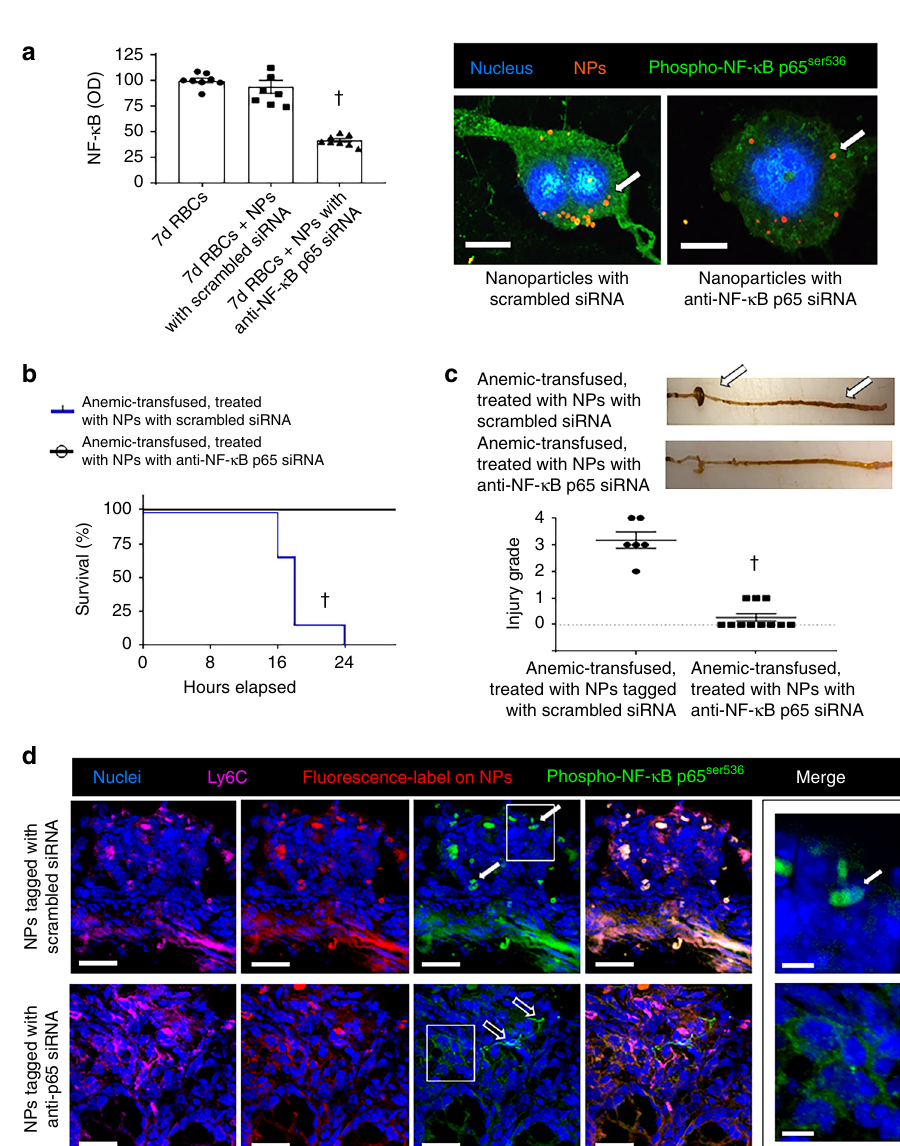
Fig. 8 Macrophages are activated during transfusion-associated necrotizing enterocolitis (NEC). a Scatter bar diagrams show nuclear factor- κ B (NF- κ B) activity in reporter cells treated with nanoparticles (NPs) containing small interfering RNA (siRNA) against NF- κ B p65 for 24 h, followed by 7-day-stored red blood cell (RBCs). Controls included no NPs or NPs containing scrambled siRNA; N = 8 donors; Kruskal – Wallis H test with Dunn ’ s post test, † P < 0.001. Fluorescence photomicrographs (magni fi cation ×2400) show “ activated ” appearance and nuclear translocation of phospho-NF- κ B p65 (green) in a macrophage treated with control NPs. Cells treated with anti-p65 NPs did not show phospho-NF- κ B p65. Arrows indicate NPs. Scale bar = 5 µ m. b Kaplan – Meier curves show survival without intestinal injury in anemic-transfused pups treated with control or anti-p65 NPs. NPs with anti-p65 siRNA were protective; Mantel – Cox log-rank test, † P < 0.001. c Photographs show intestinal injury in an anemic-transfused pup treated with control NPs (arrows), but no injury in a pup treated with NPs containing anti-p65 siRNA. Scatter plots below summarize the severity of bowel injury in the two groups. N = 6 anemic-transfused mice treated with control NPs, 11 anemic-transfused treated with anti-p65 NPs; Mann – Whitney U test, † P < 0.001. d Fluorescence photomicrographs (magni fi cation ×400) of proximal colon from anemic-transfused mice treated with either control or anti-p65 NPs show immunoreactivity for Ly6C (magenta), fl uorescence tag on NPs (red), and phospho-NF- κ B p65 (green). Mice treated with control NPs show tissue damage and nuclear translocation of phospho-p65, whereas those treated with anti-p65 NPs show preserved histoarchitecture and no immunoreactivity for phospho-p65 in Ly6C + macrophages. Cytoplasmic staining for phospho-p65 was seen in two cells (open arrows) that did not express Ly6C. Scale bar = 50 µ m. High-magni fi cation photomicrographs on right (×2000; phospho-p65 staining in area in boxes) highlight nuclear localization (arrow) of phospho- p65 in the control NP group; N = 5 mice per group. All scatter plots summarize the data as means ± standard error of the